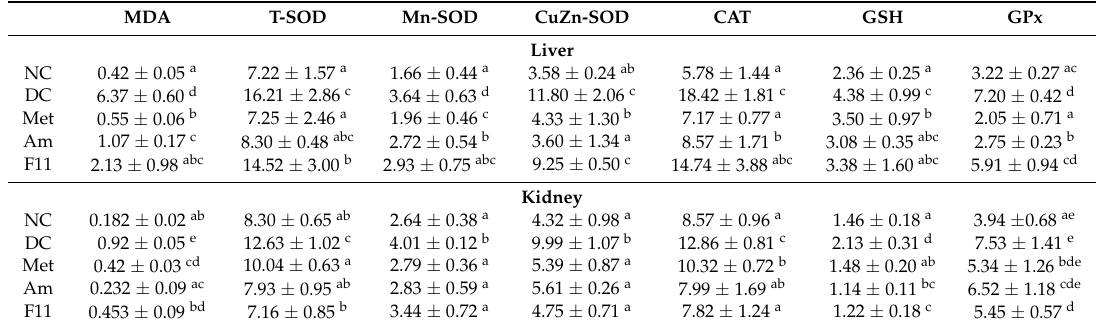
Table 4. Levels of antioxidant enzymes and oxidative stress markers in liver and kidney. MDA